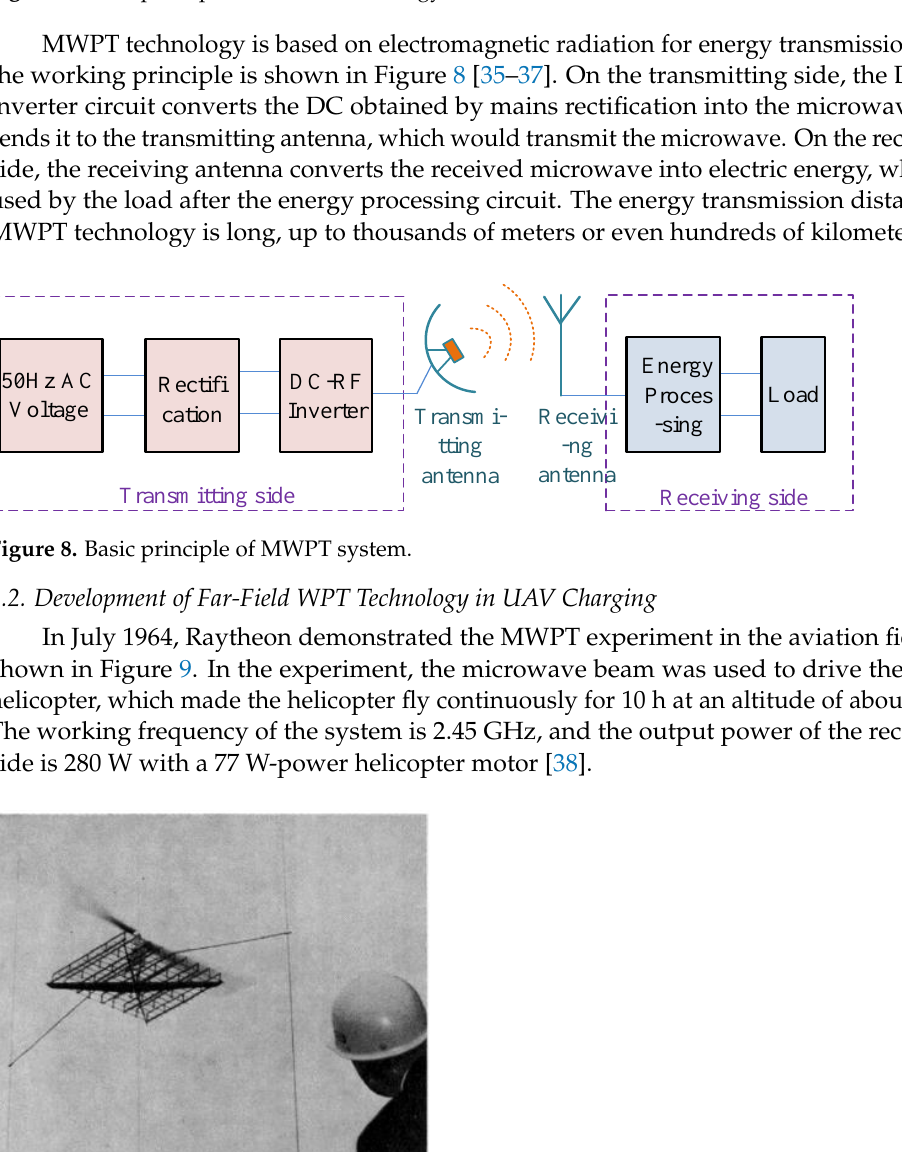
Figure 7. Basic principle of LWPT Technology.